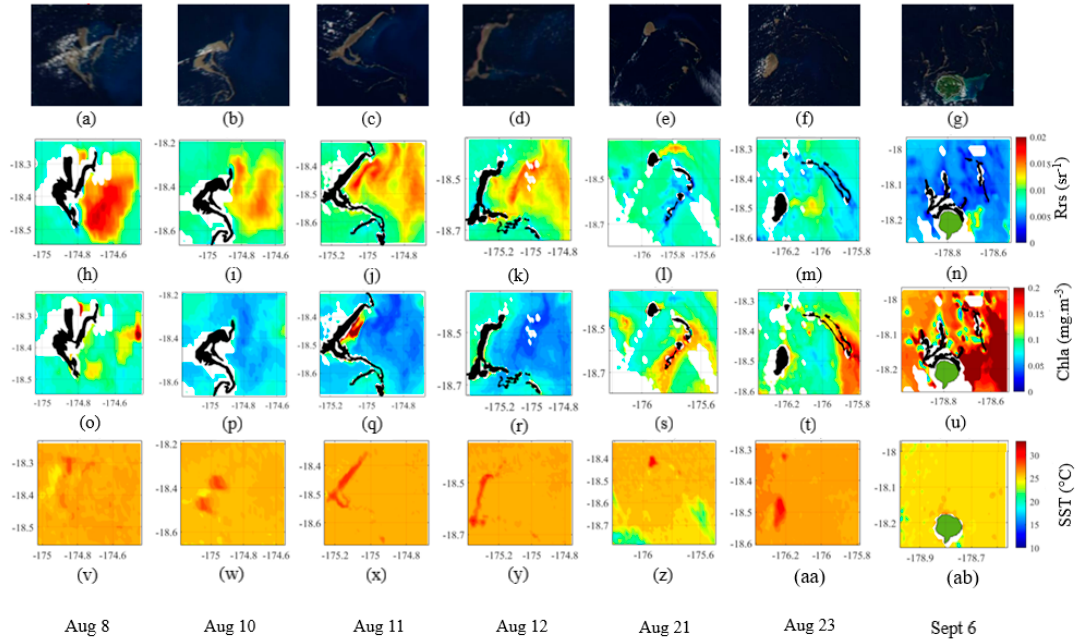
Figure 4. Series of true color (first row) and results of different masks obtained on L2 products outlining parameters of extracted, consolidated, and fragmented pumice rafts; discolored waters (corresponding to the backscattering coefficient at 443 nm > 0.0032 m − 1 ); and mesotrophic waters (Chla > 0.1 mg · m − 3 ) during the 8 August–6 September series. The second row represents remote sensing reflectance (Rrs) at 443 nm, the third row chlorophyll-a concentration (Chla), and the last row SST images. Dates at the bottom are aligned to columns directly above them. The white pixels correspond to cloud cover in Rrs at 443 nm and Chla images. The black pixels correspond to the pumice raft associated with the L2 SST mask and two QC L2 flags.